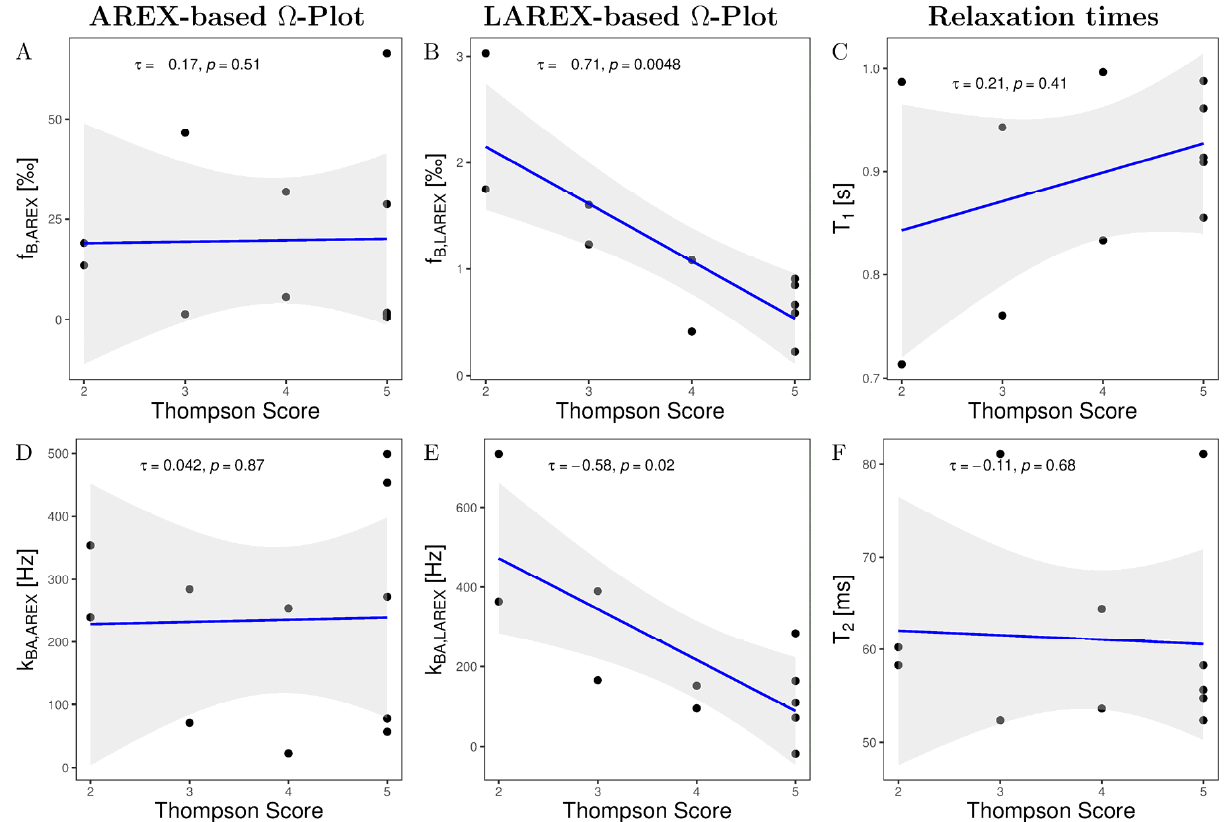
Figure 2. Kendall-Tau correlations of altered GAG fractional concentrations f b ( A , B ), T 1 relaxation times ( C ), GAG exchange rates k ba ( D , E ), and T 2 relaxation times ( F ) as a function of Thompson scoring in our measured in situ IVDs. In all correlation diagrams, a black dot corresponds to the mean value of the studied parameter for a single IVD and the gray background illustrates the 95% confidence interval of the correlation. ( A ) AREX-based fraction concentrations show a non-significant and negligible decrease with Thompson scoring. Moreover, AREX-based fractional concentrations scatter in a non-physiological range. ( B ) The LAREX-based determination shows a strong and significant decrease as a function of Thompson scoring. ( C , F ) Both Relaxation times show a non-significant correlation as a function of Thompson scoring. ( D ) AREX-based exchange rate determination shows no correlation as a function of Thompson rating. ( E ) The LAREX-based determination shows a strong and significant decrease as a function of the Thompson